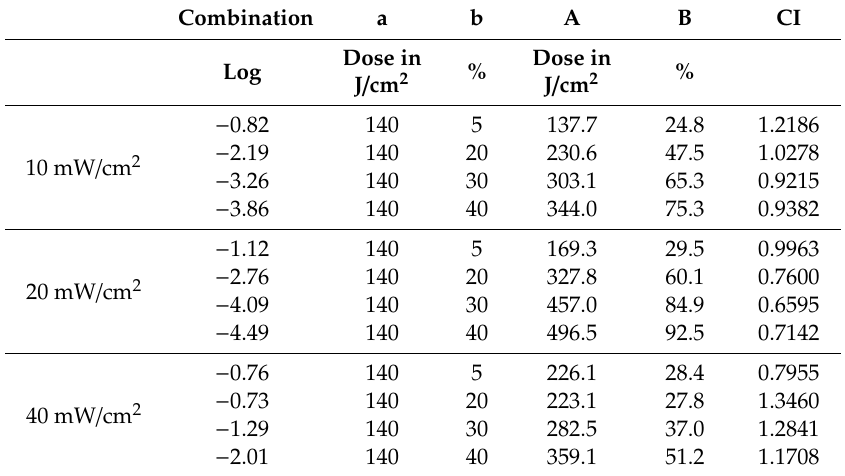
Table 1. Combination Index values calculated based on Loewe Additivity for log reduction results on agar plates achieved with ReNu Multiplus and 405 nm on P. fluorescens .